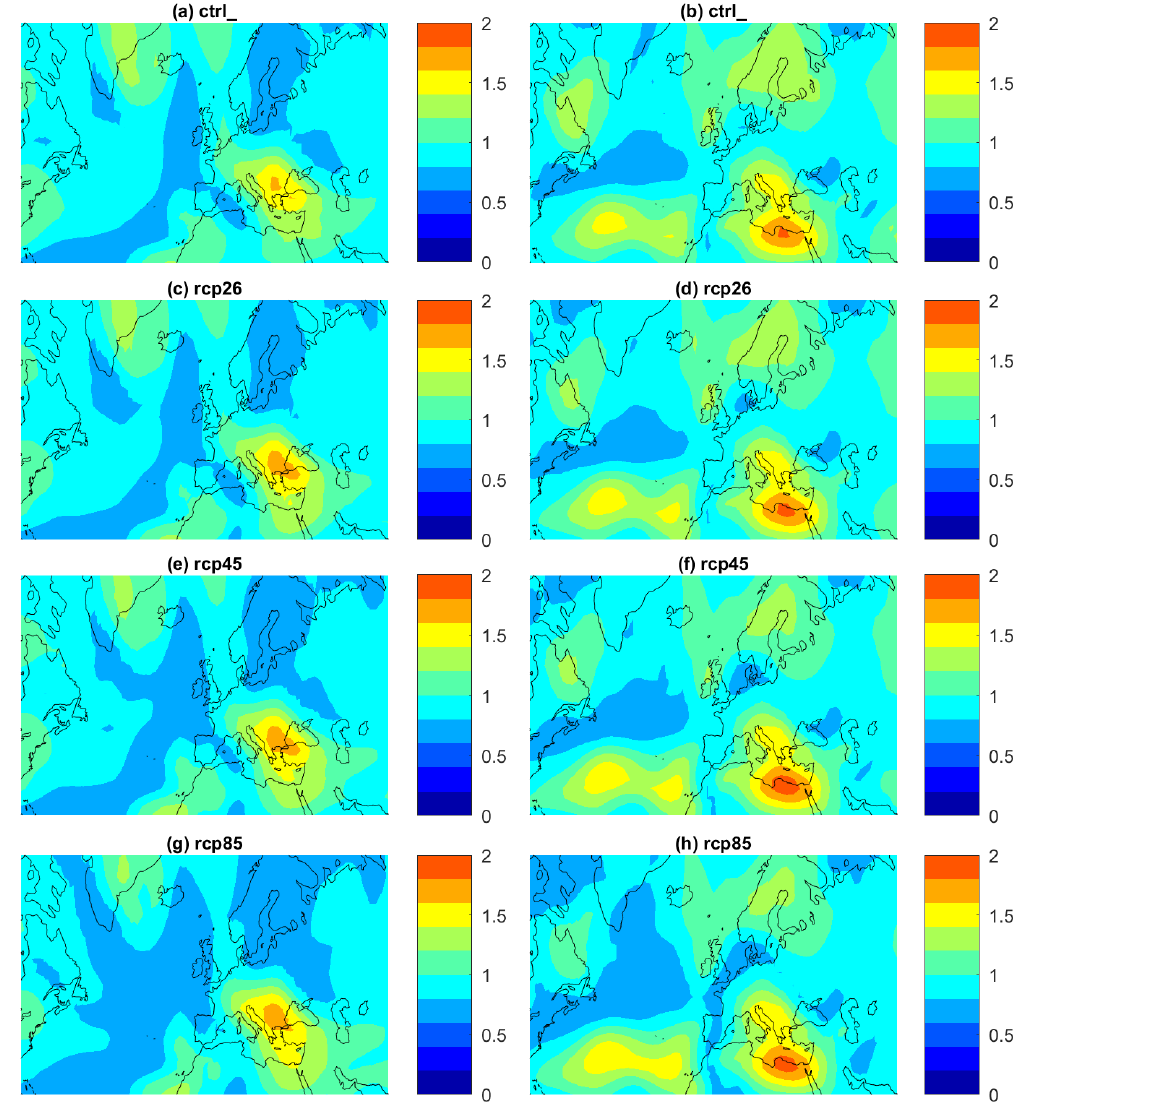
Figure B3. The figure shows 850hPa temperature uncertainty in PlaSim analogues: root mean squared difference in standardized 850hPa temperature (standard deviations) between analogues and cluster centroids for cluster 1 (a, c, e, g) and cluster 2 (b, d, f, h) . (a, b) Control run. (c, d) RCP2.6 run. (e, f) RCP4.5 run. (g, h) RCP8.5